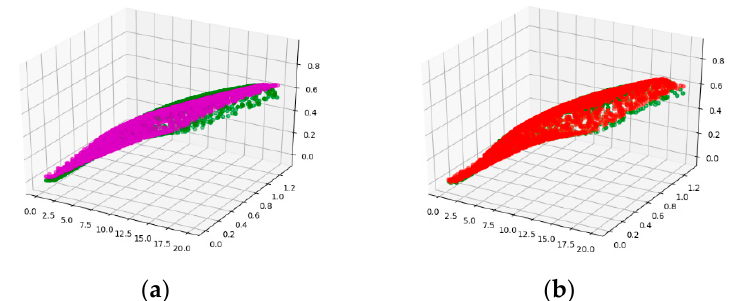
Figure 9. The three-dimensional fitting results of the atmospheric transmittance. ( a ) Training 200 epochs; ( b ) training 300 epochs.